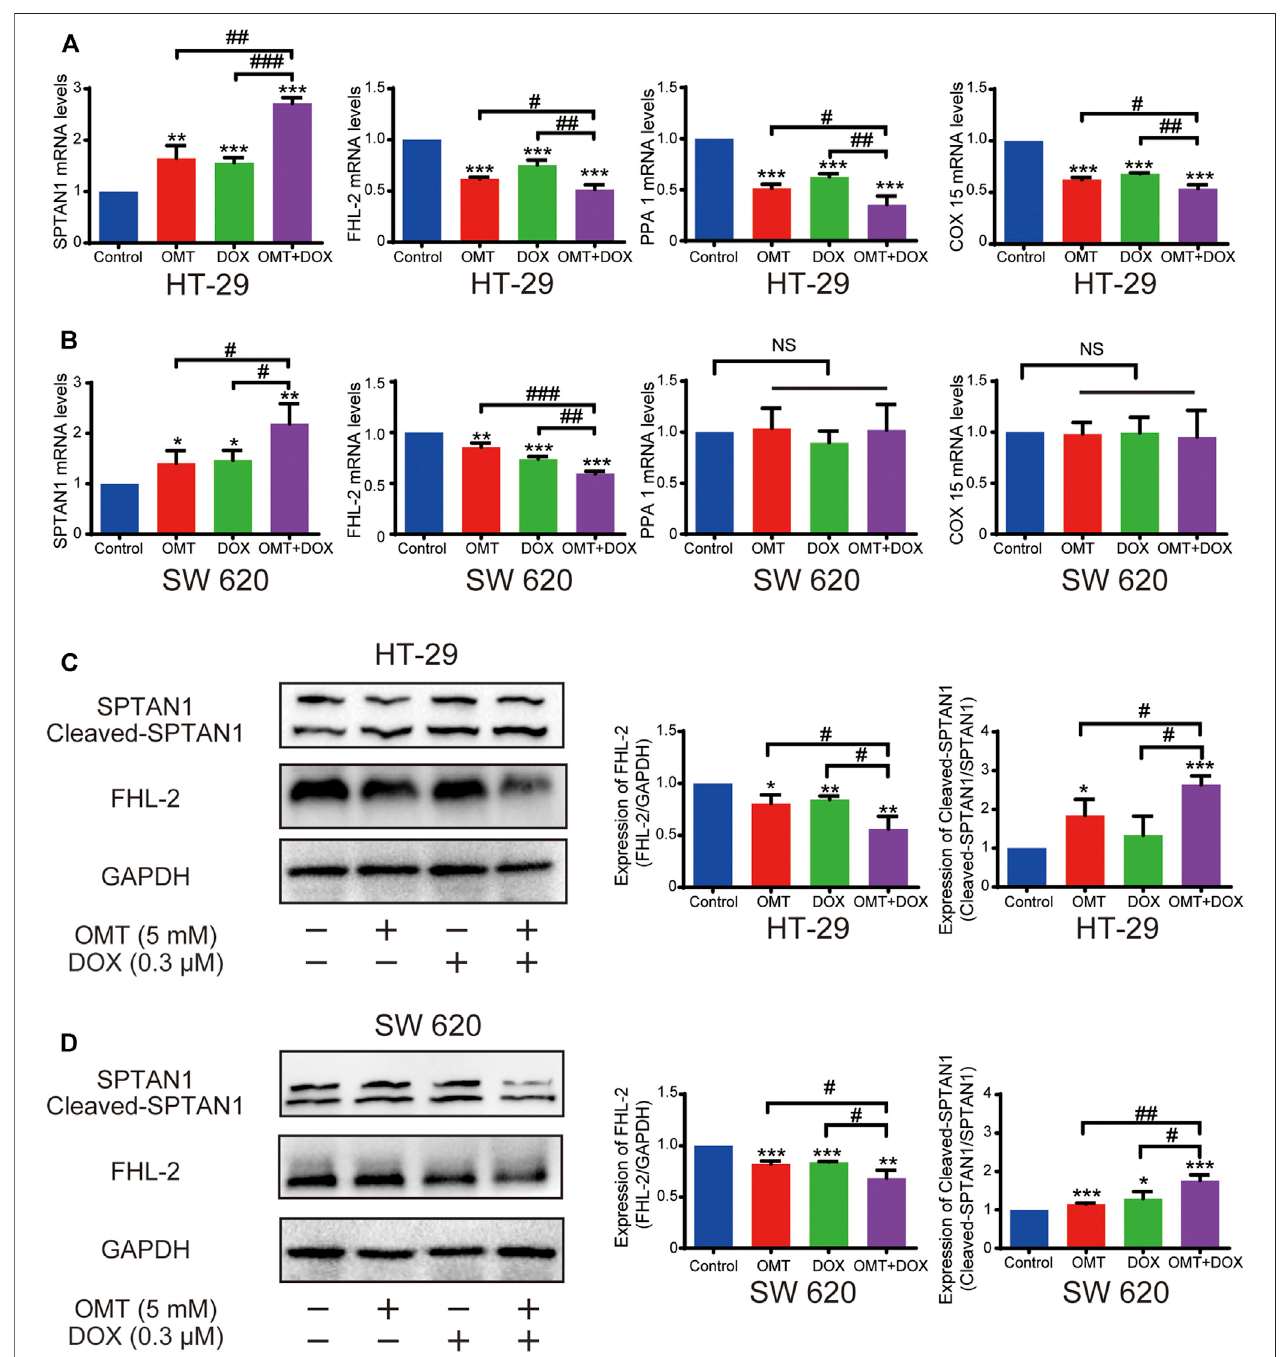
FIGURE8| Effects ofOMTand DOXon FHL-2and SPTAN1 inCRCcells. (A,B) mRNAexpression ofSPTAN1, FHL-2, PPA1,and COX 15onHT-29 and SW620. HT-29 (A) and SW620 (B) . (C – D) Western blotting assay was used to analyze the protein expression level of SPTAN1, cleaved-SPTAN1, and FHL-2 in HT-29 and SW620 cells; the densitometric analysis of every factor was performed and was normalized with the corresponding GAPDH content. Data are presented as the mean ± SD of three independent experiments. * p < 0.05, ** p < 0.01, *** p < 0.001 vs. the control group; # p < 0.05, ## p < 0.01, ### p < 0.001 vs. the OMT (5 mM) group or DOX (0.3 μ M)